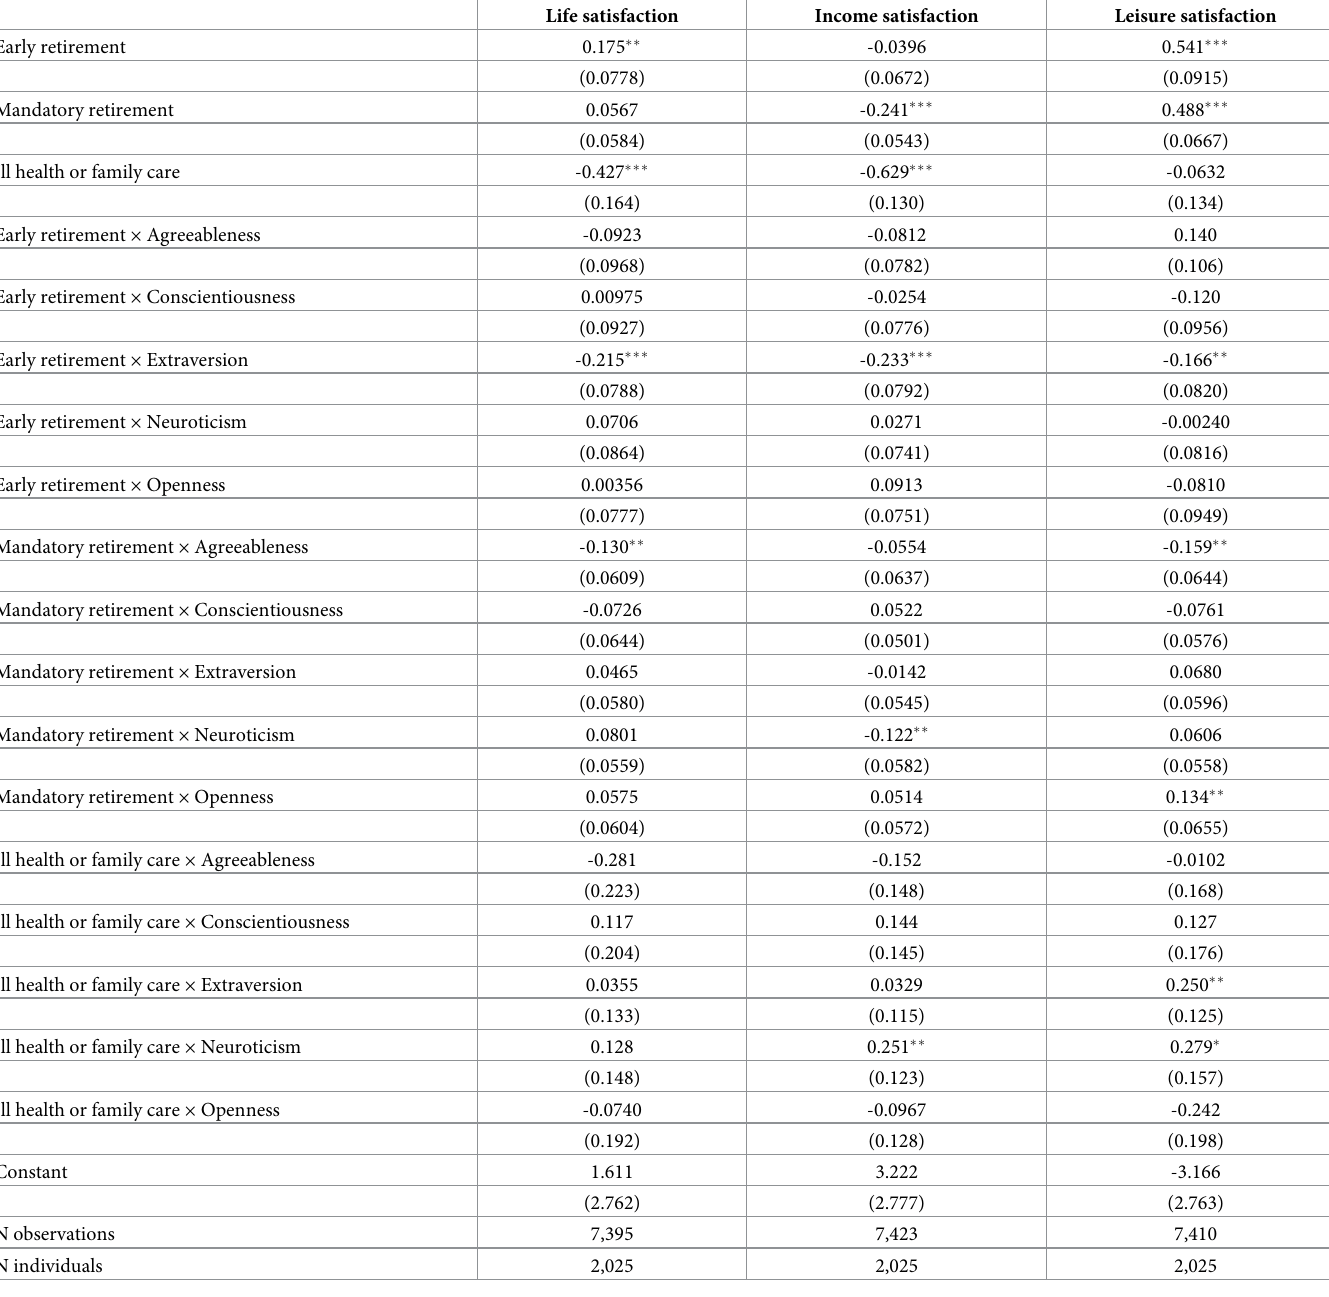
Table 7. Exit pathways, personality traits and well-being excluding those who are